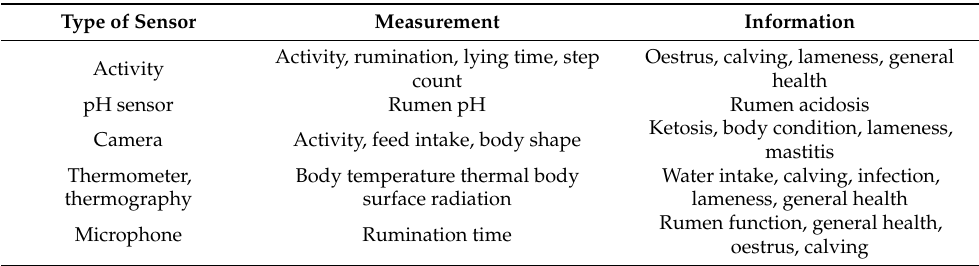
Table 1. Examples of the sensors used in dairy farming, what they measure and what the alarm signal can inform the stockperson